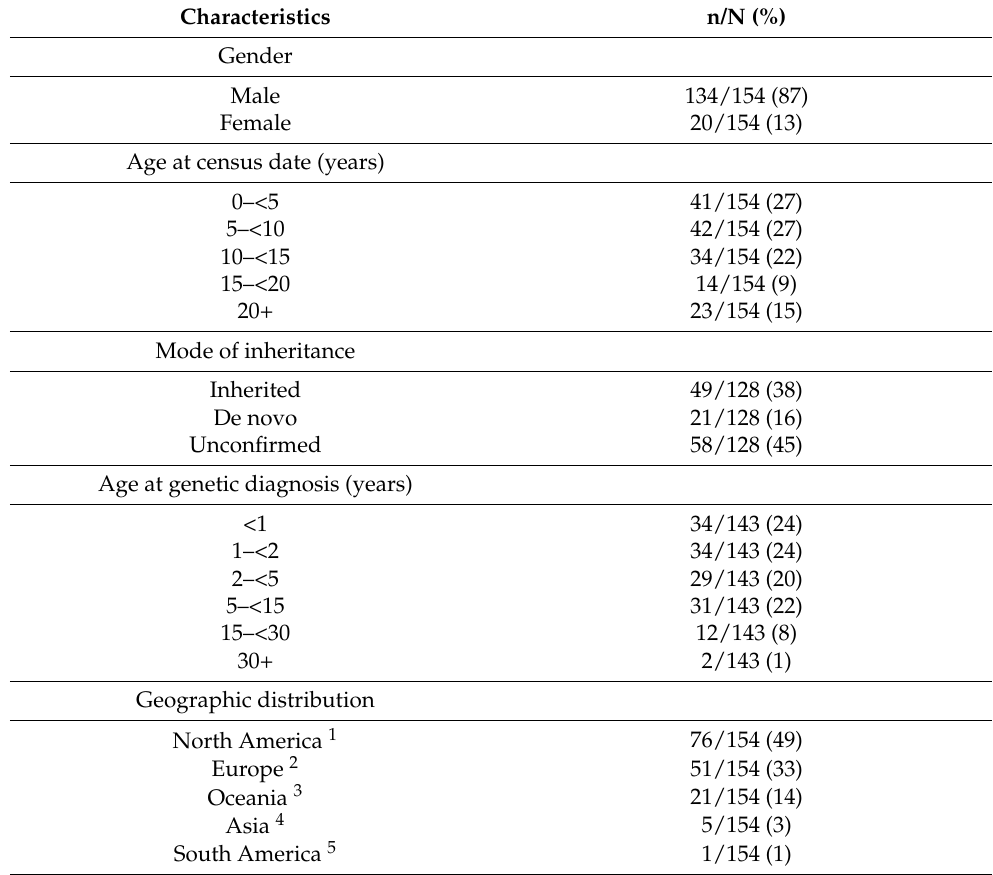
Table 2. Cohort characteristics of the international MECP2 Duplication Database (MDBase) from data collected to March